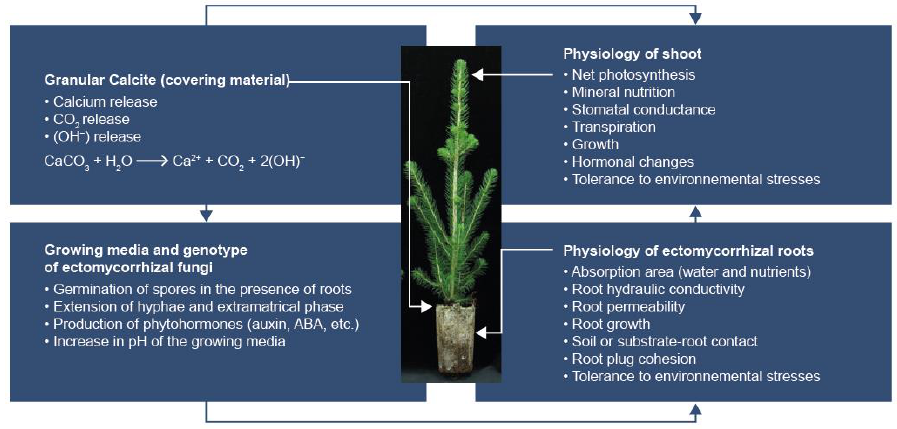
Figure 6. Main mechanisms by which calcite and ectomycorrhizae improve the physicochemistry of the substrate, and the growth and physiology of plants.